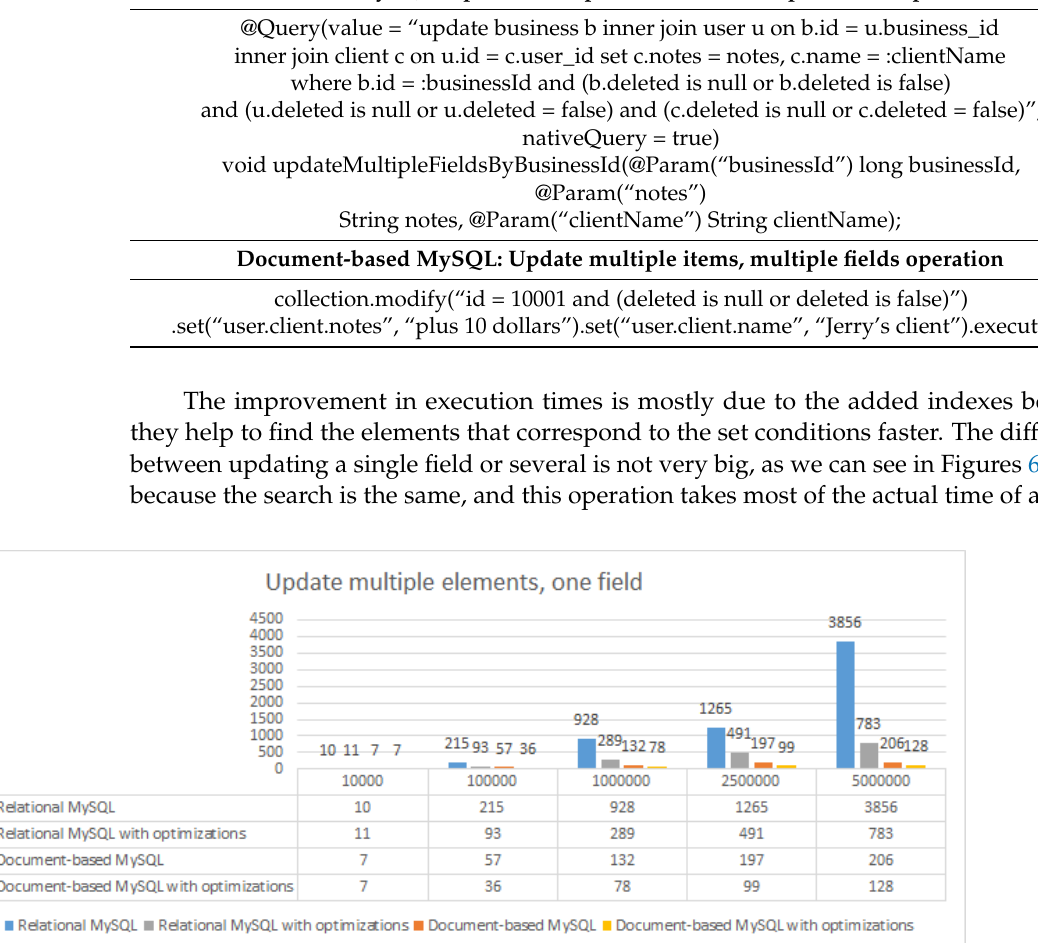
Figure 7. Performance time (ms) for the update multiple elements and multiple fields operation. The improvement in execution times is mostly due to the added indexes because they help to find the elements that correspond to the set conditions faster. The difference be- tween updating a single field or several is not very big, as we can see in Figures 6 and 7, because the search is the same, and this operation takes most of the actual time of a query. When there is a small number of elements, the results for updating operations are similar because the search is relatively fast, but with the increase in the number of ele- ments and the lack of indexes, relational MySQL takes a very long time compared with document-based MySQL. After applying the optimization methods on both databases, we can see from Figures 6 and 7 that document-based MySQL is faster than relational MySQL, but timing improvements are significant for relational MySQL. We noticed, as a result of the tests performed, that the indexes have a huge impact; thus, the proposed optimization methods, described above, help with gaining an im- provement in the execution time over 60% in the case of both databases. 5.3. Select Operation We further analyzed several select operations in order to better observe the result of the proposed optimization methods. The selection operations performed are a simple se- lect operation, based on the primary key of the table; a select operation that uses a join based on the name field in the business table; a select operation that uses two joins also based on the business name; a select operation with multiple joins and different functions based on the business_id field in the user table; and a select operation with two left joins and different functions. All selections exclude deleted items from all tables. 5.3.1. Simple Select Operation To exemplify a simple select operation, for example, a business by its id , in the case of relational MySQL, we used a select statement; in the case of document-based MySQL,